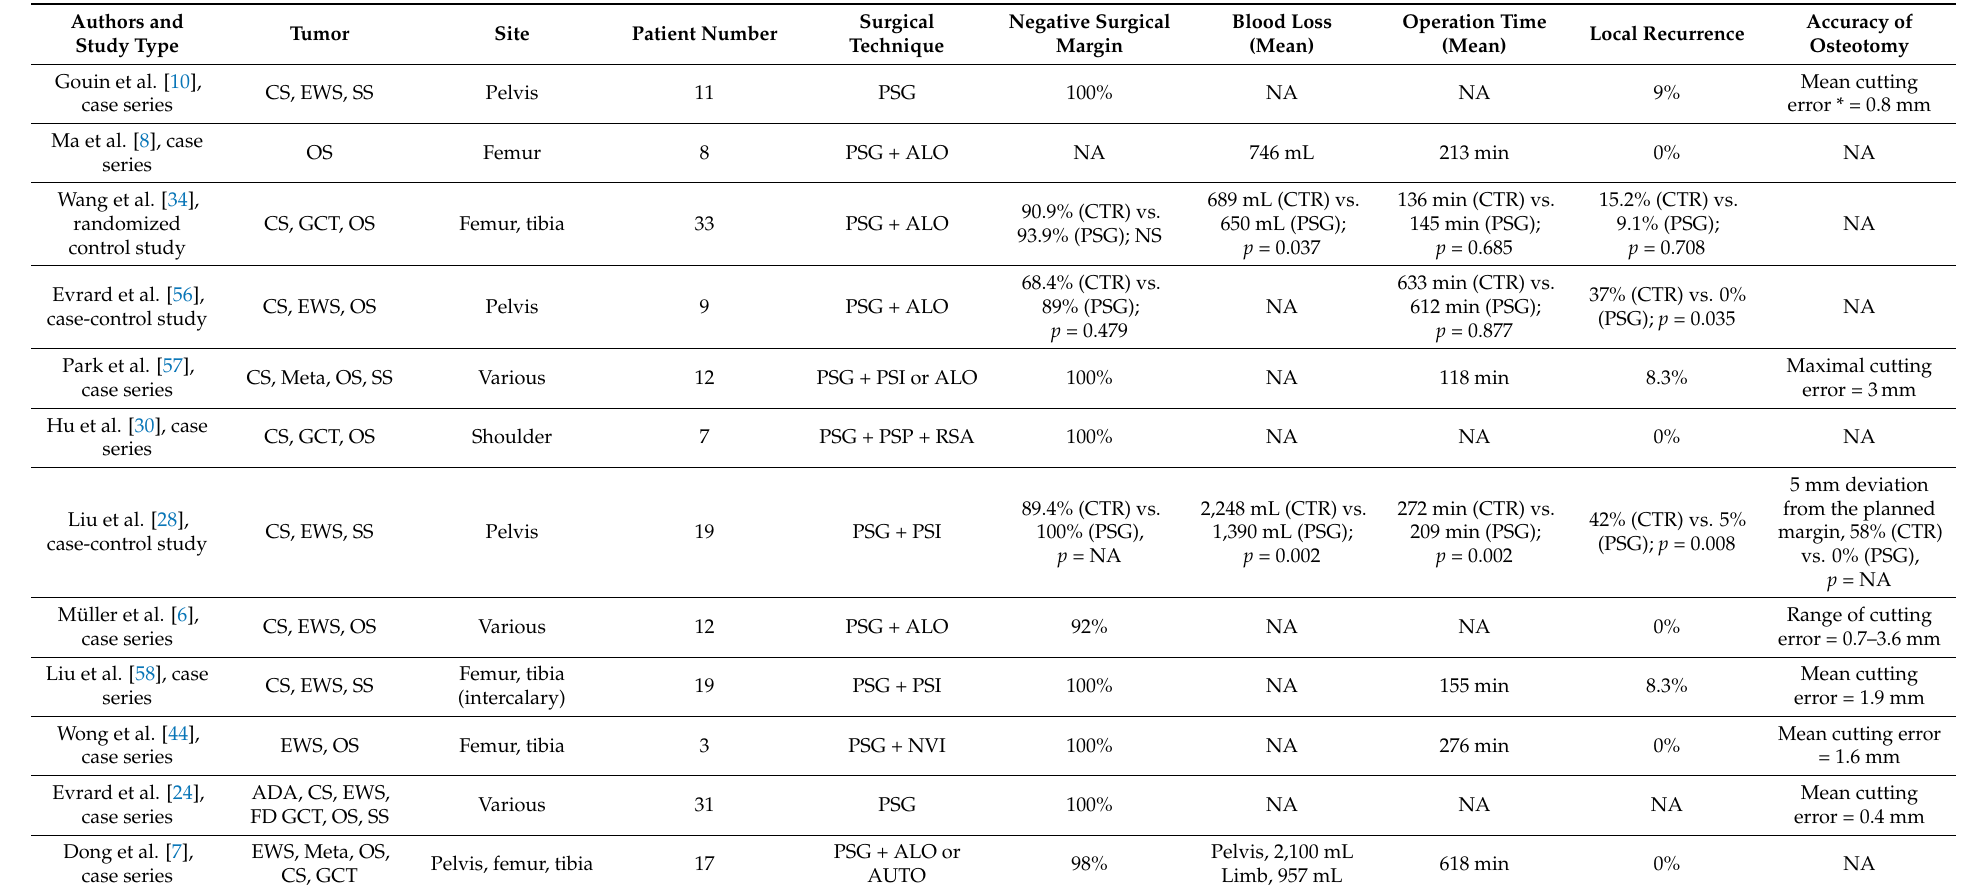
Table 2. Clinical studies investigating PSGs for the resection of bone